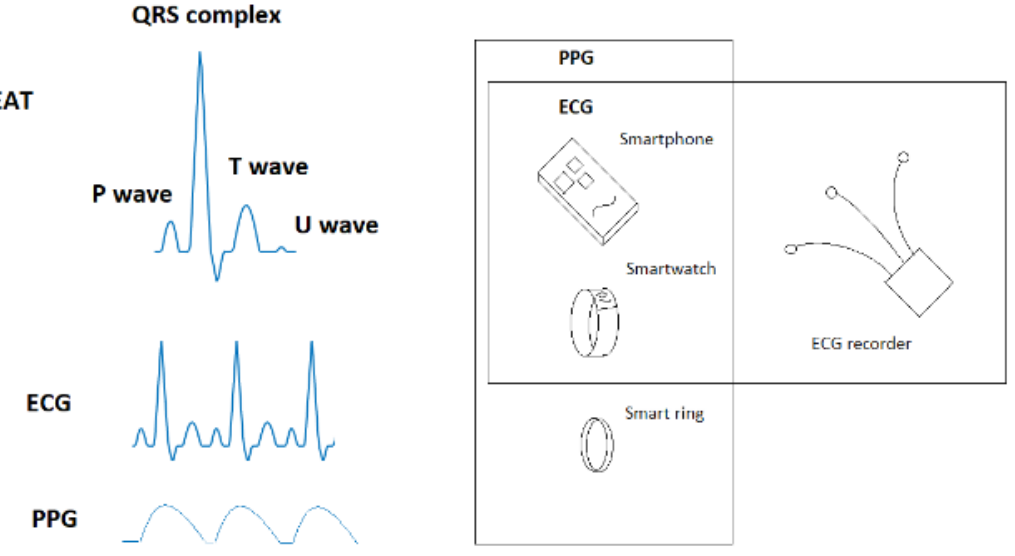
Figure 1. Wearable devices and recording options.